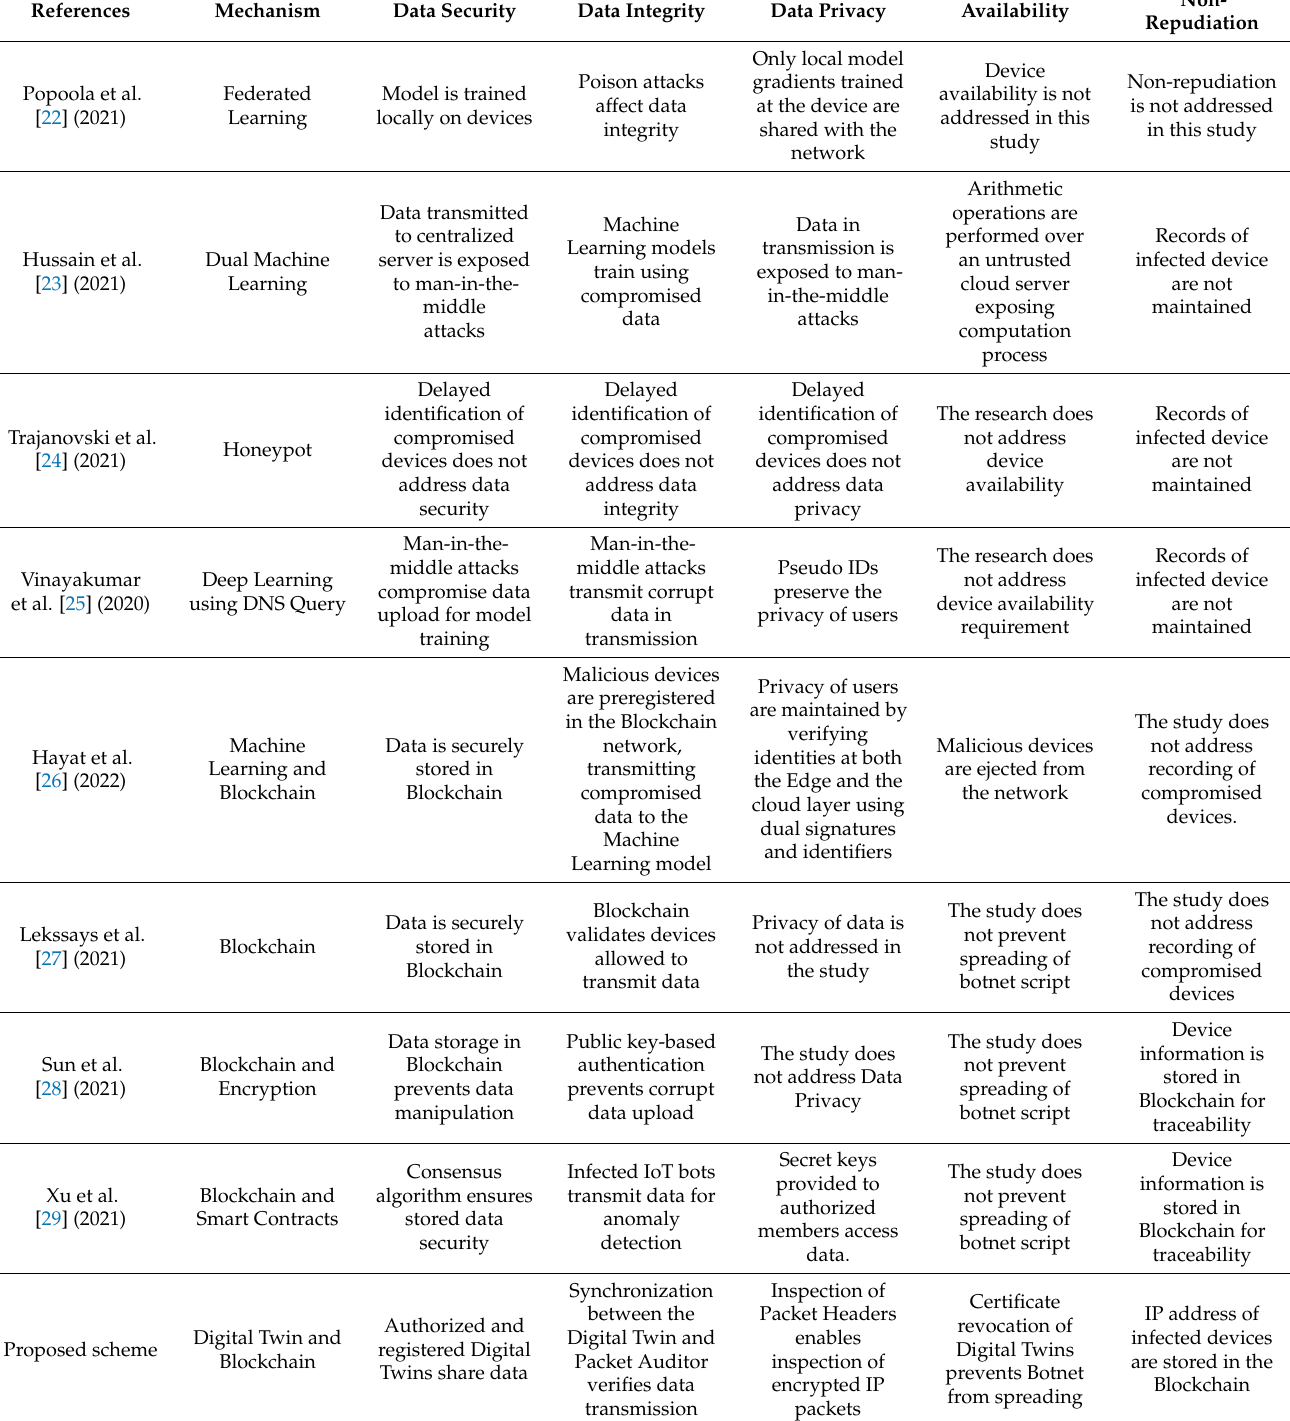
Table 1. Comparative Analysis of the proposed scheme with related